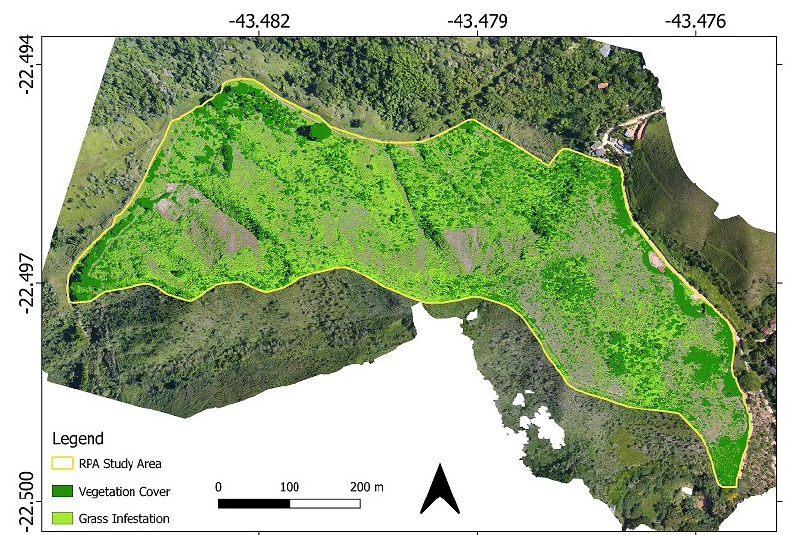
Figure 6. The Vegetation Cover and Grass Infestation results of the RPA study